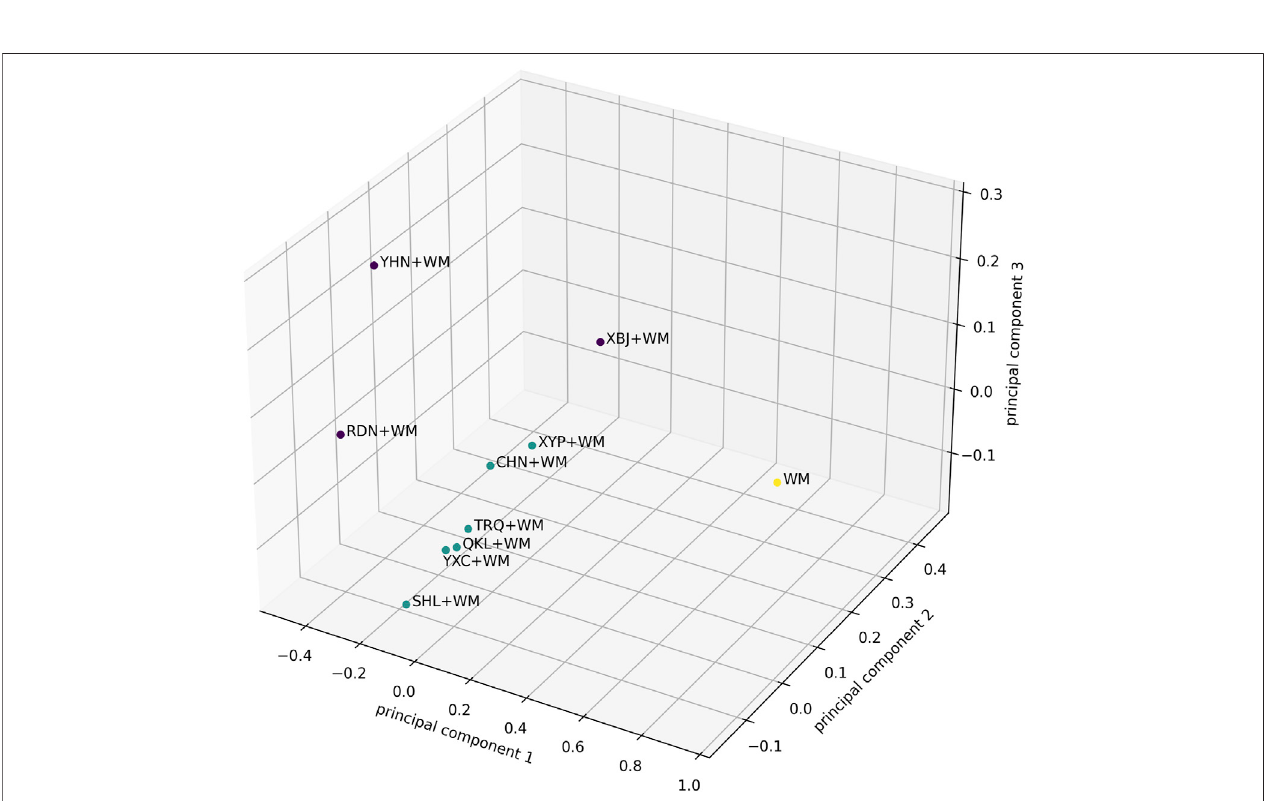
FIGURE 4 | The results of the 5-Dimensional K-means cluster analysis were reduced to three dimensions by principal component analysis. The purple dots representthebest categoryofcurative effect,whilethegreendots arethe secondand the yellow dotsarethe worst. Theaxes represent the threeprincipalcomponents in the principal component